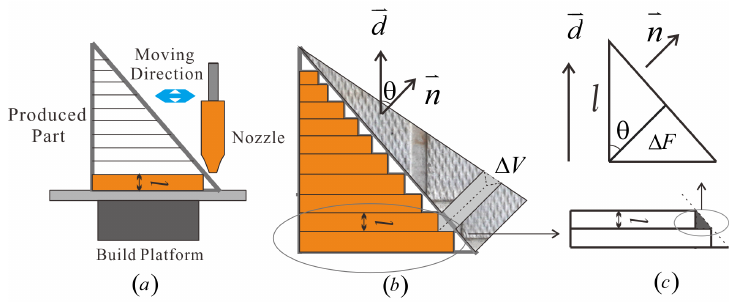
Figure 1. Staircase effect analysis: ( a ) 3D printing process. ( b ) Volume error between two layers. ( c ) Estimation of volume